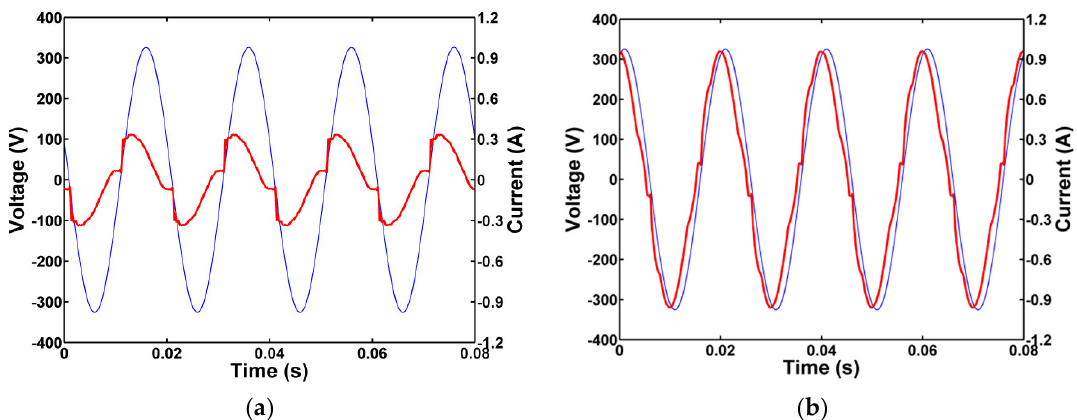
Figure 9. Waveforms of voltage and current for luminaire marked as LED3 for: ( a ) 10% dimming level and ( b ) 100% dimming level. Table 10. List of measured selected RMS values of harmonics I h in relation to the basic harmonics for LED3